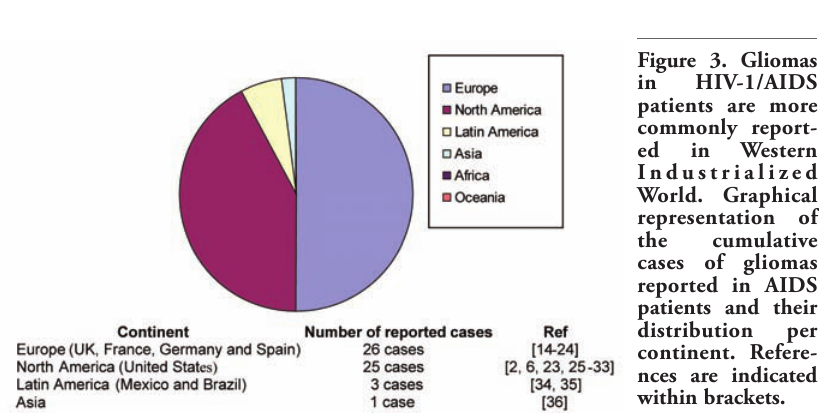
Figure 2. Reports of gliomas in HIV- 1/AIDS patients follow a Gaussian distribution dur- ing the first three decades of the epi- demic. Graphical representation of the total number of gliomas reported in Mexico/Brazil and the rest of the world, are indicated within brackets.